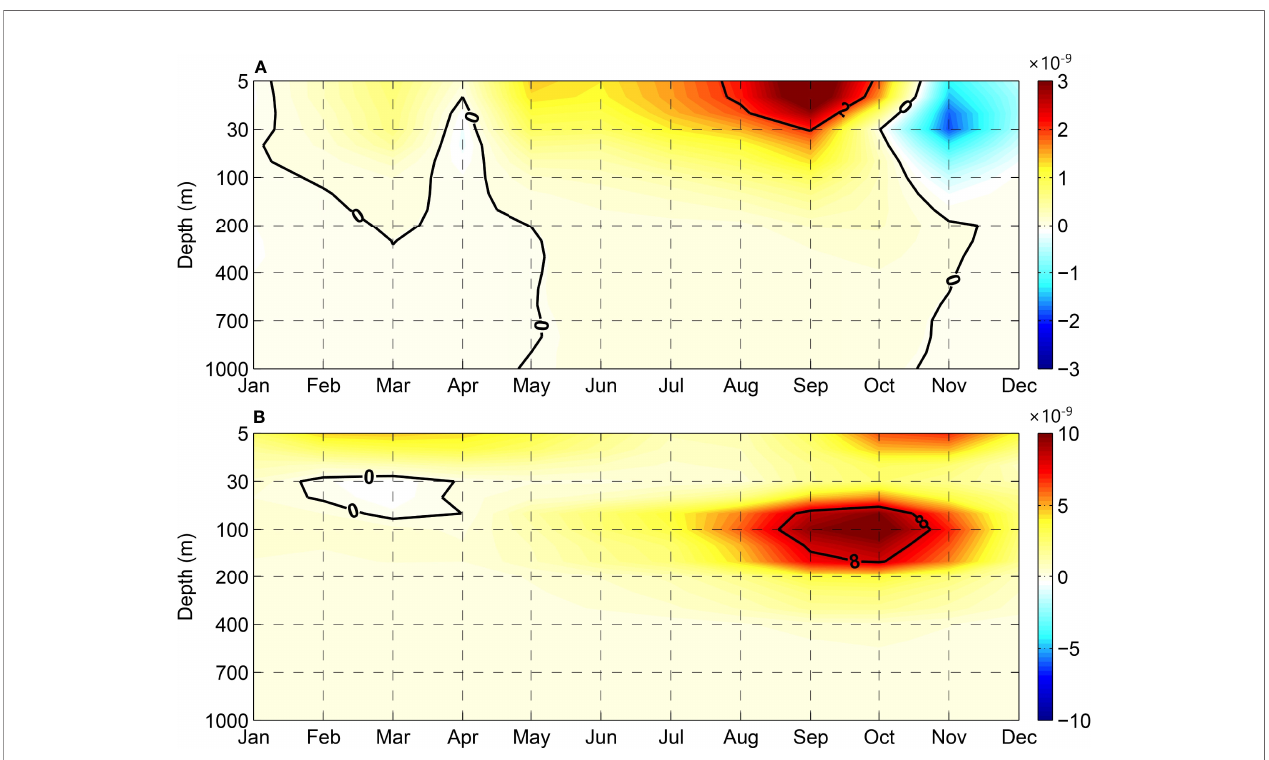
FIGURE 7 | Seasonal variation of BTR (A) and BCR (B) averaged in the area (10° – 14°S, 105° – 115°E). Units for BTR and BCR are m 2 /s 3